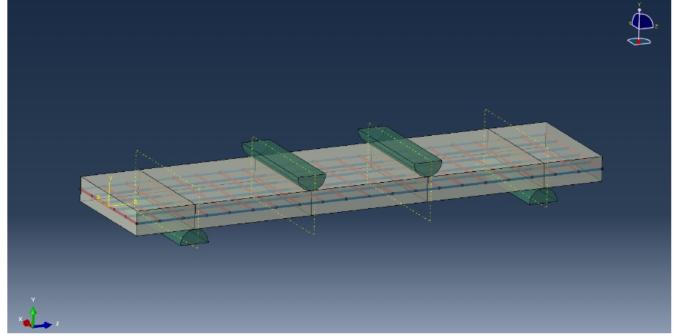
Figure 12. Assembly completed drawing of